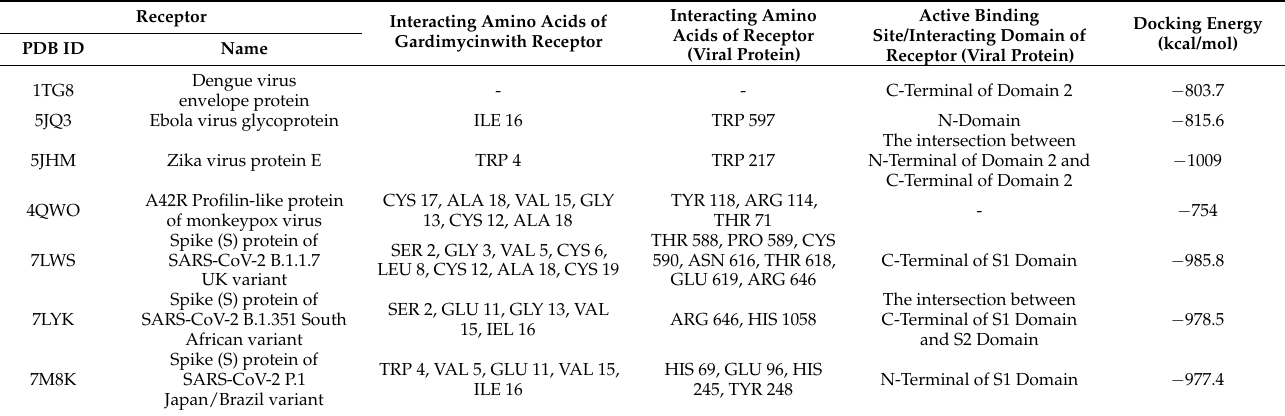
Table 7. Molecular docking analysis of gardimycin (PDB ID: 1AJ1) derived from A. garbadinensis